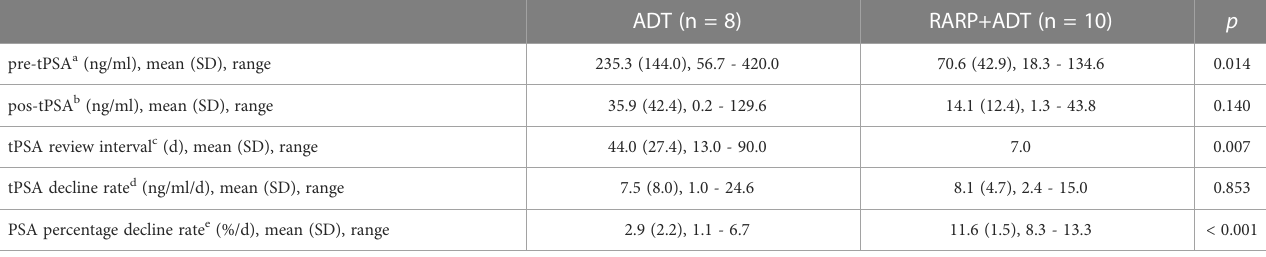
TABLE 3 tPSA decline rate and tPSA percentage decline rate.